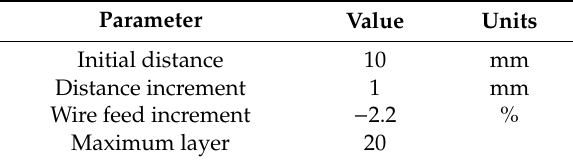
Table 2. Bead termination routine parameters.